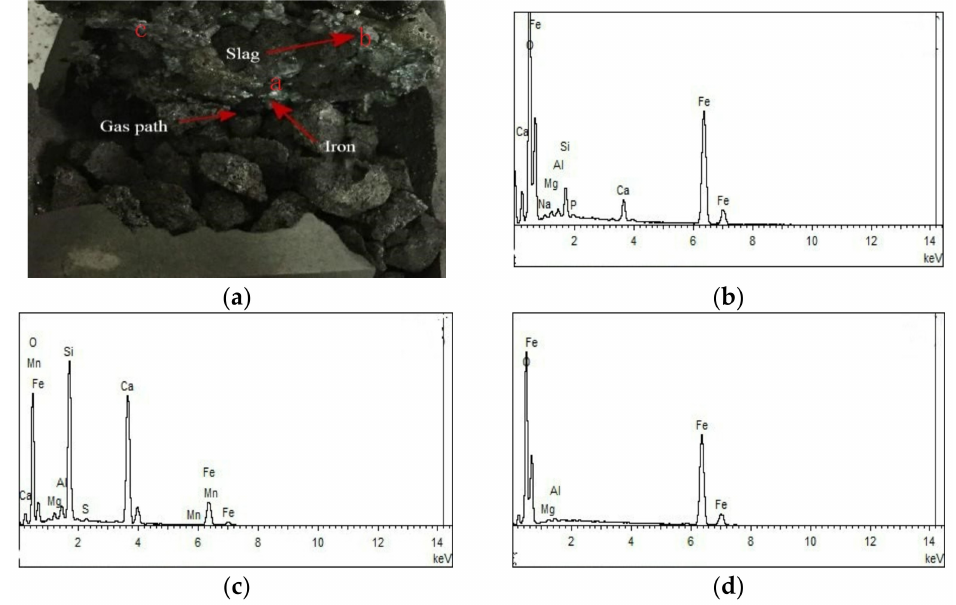
Figure 7. SEM observation of typical nondropped materials. ( a ) Appearance of typical nondropped materials, ( b ) SEM scanning of point a, ( c ) SEM scanning of point b, ( d ) SEM scanning of point